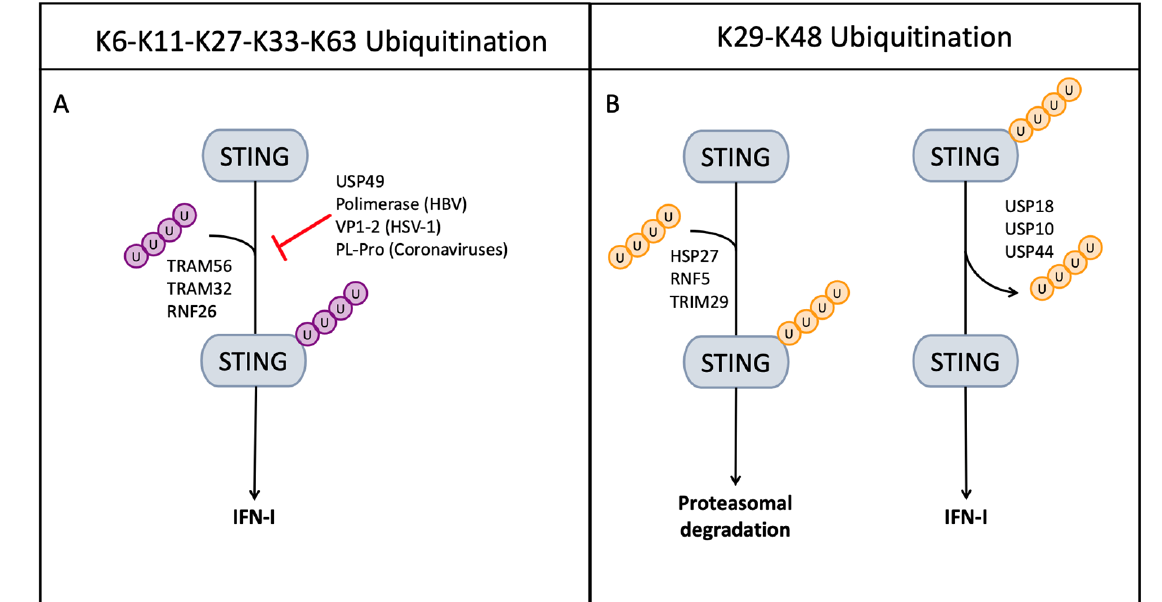
Figure 6. STING ubiquitination. ( A ) K6–K11–K27–K33–K63 ubiquitination is required to induce STING activation and IFN-I transcription; viral proteins as well as cellular proteins inhibit the IFN response by deubiquitinating or inducing deubiquitination. ( B ) K29–K48 ubiquitination is the signal for proteasomal degradation; in viral-infected cells, this ubiquitination is promoted and the cellular